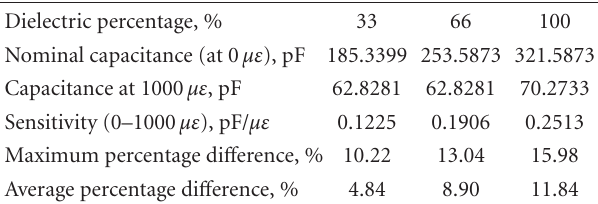
Table 6: Simulation results for di ff erent dielectric